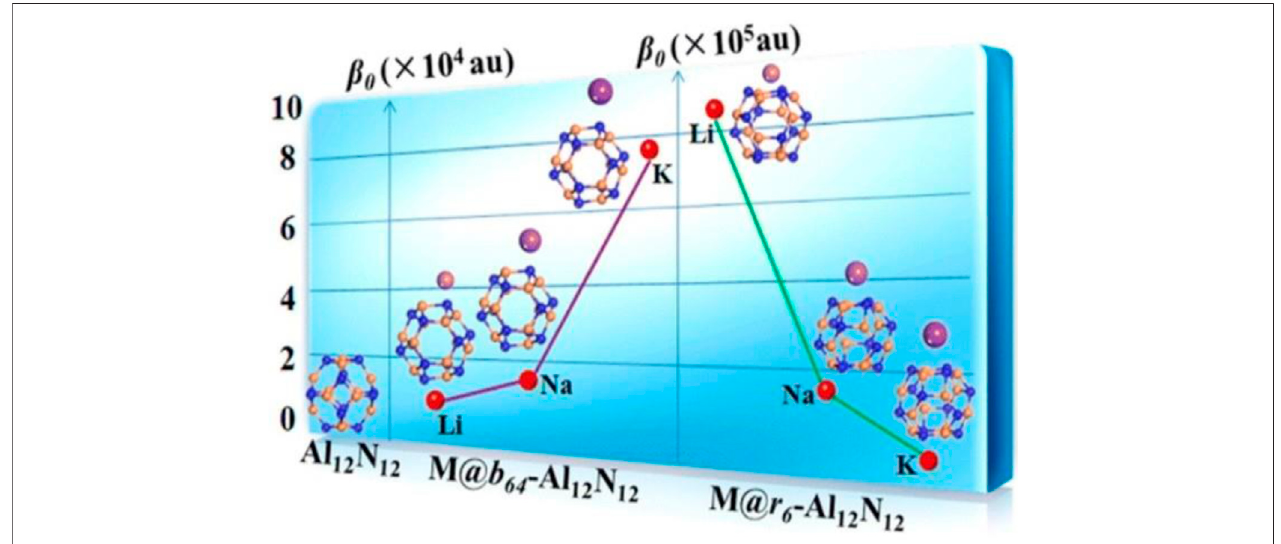
FIGURE 9 | Alkali metal doping at various positions of M@ x -Al 12 N 12 nanocage ( x (cid:1) b 64 , and r 6 ). Reprinted with permission from Niu et al., 2014. Copyright (2014) American Chemical Society.